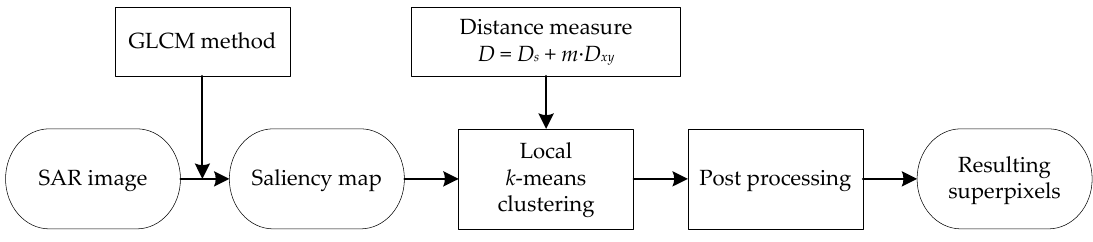
Figure 7. The flow chart of the proposed pixel saliency difference and spatial distance (PSDSD) method.